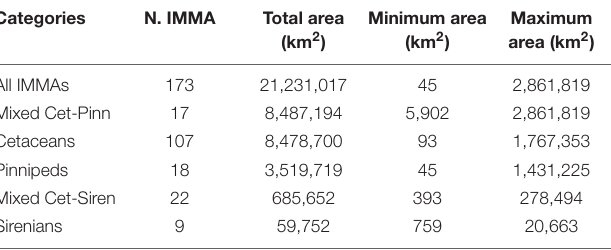
TABLE 2 | Descriptive statistics of the size of